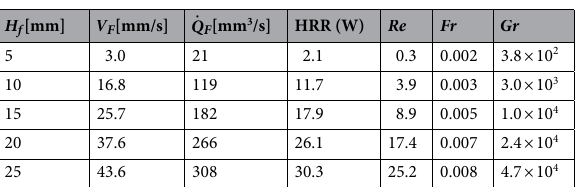
Figure 1. ( a ) The schematic of gas burner and sound source, ( b ) sound pressure distribution on the plane 100- mm away from the speaker 15 , ( c ) the decay of sound pressure with the distance to the speaker membrane, and ( d ) the corresponding flame characteristics.